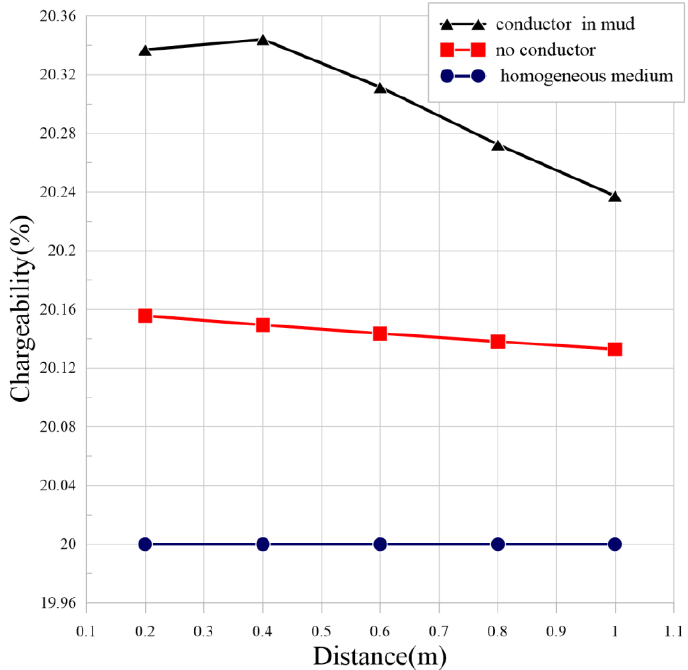
Figure 7. Influence of the positions of the non-polarized electrodes in the device.